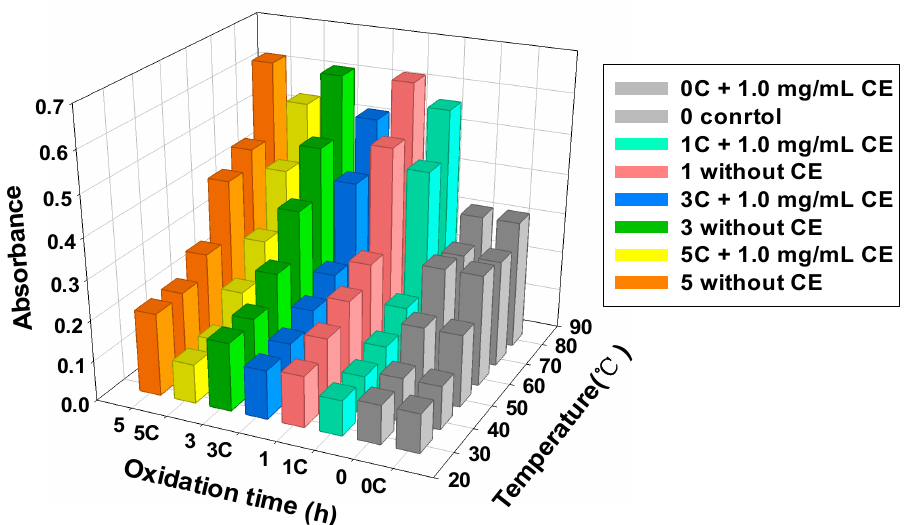
Figure 5. Effect of CE on MPs turbidity at different oxidation times. 0 and 0 C, not oxidized; 1 and 1 C, oxidized for 1 h; 3 and 3 C, oxidized for 3 h; 5 and 5 C, oxidized for 5 h. C, oxidized for 1 h; 3 and 3 C, oxidized for 3 h; 5 and 5 C, oxidized for 5